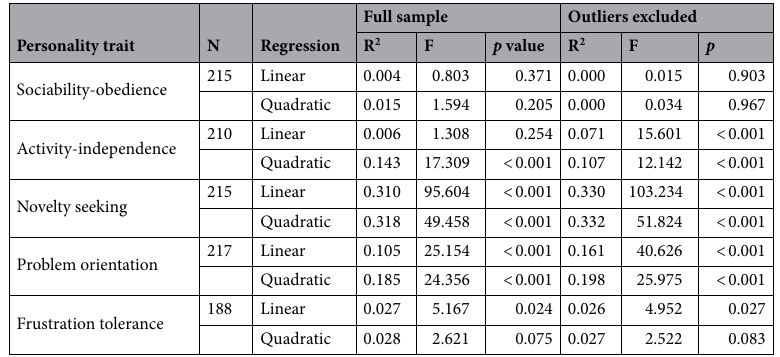
Table 1. Relationship between the five personality traits and the age of the dogs in the full sample, and after excluding four outlier aged dogs. The results of both the linear and quadratic regressions are